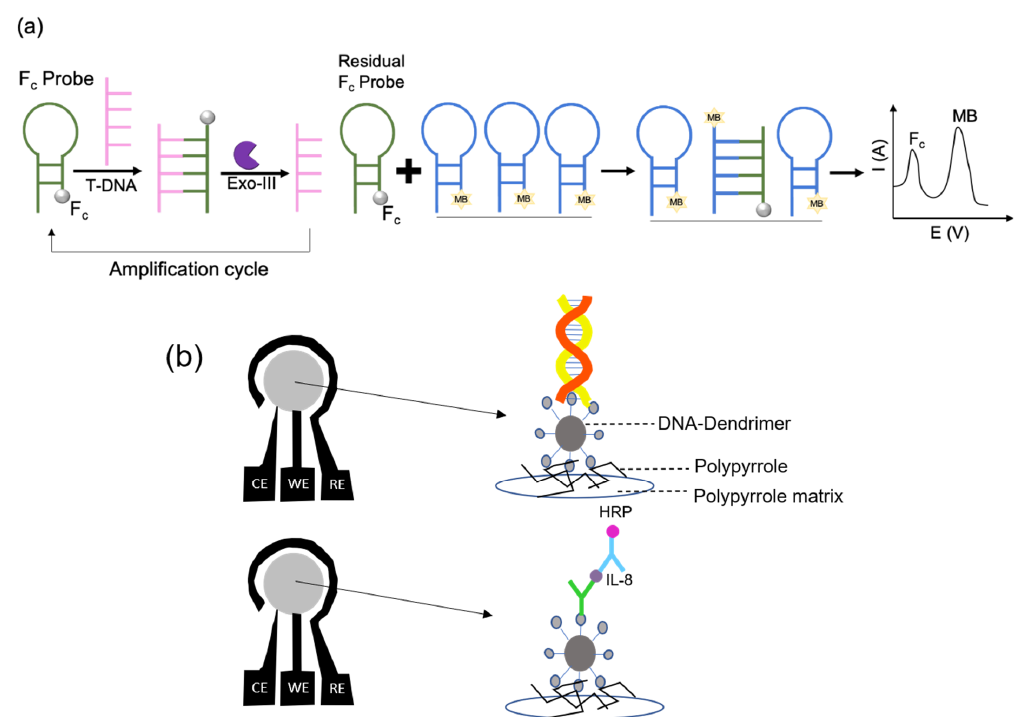
Figure 2. ( a ) Schematic illustration of the Exo-III involved in the DNA target amplification cycle and the signal readout of electrochemical DNA biosensor. ( b ) The three-electrode configuration on the electrochemical chip and illustration of biomolecules immobilize on DNA dendrimer. Abbreviations: Ferrocene-labeled hairpin probe (Fc); Exonuclease III (Exo-III); Methylene blue (MB); Counter electrode (CE); Working electrode (WE); Reference electrode (RE); Horseradish